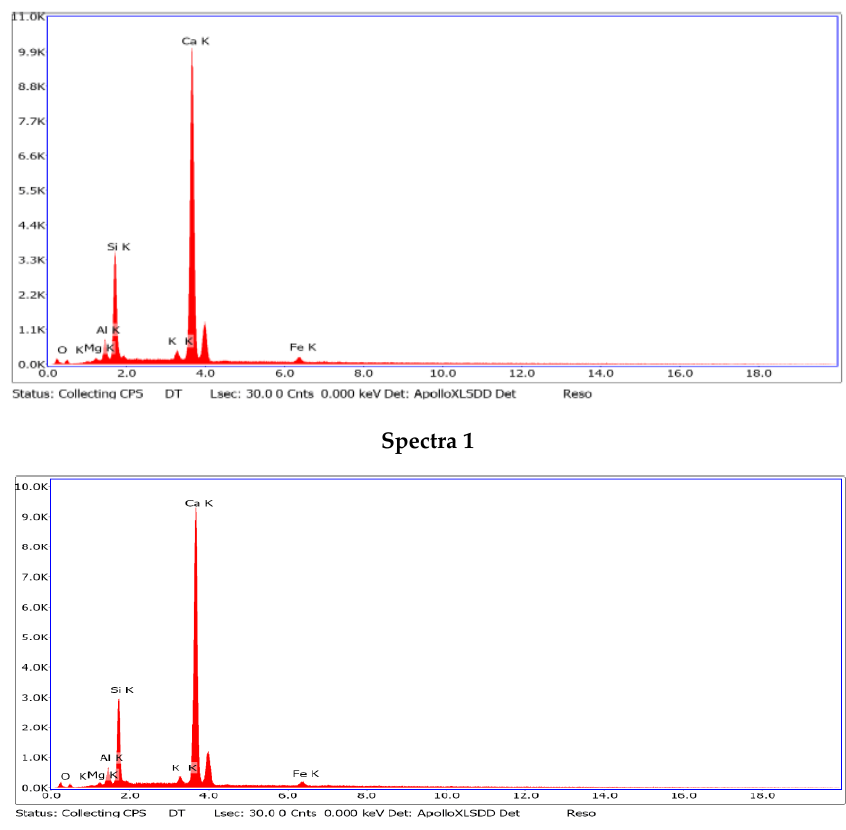
Figure 3. EDS spectra phases of the initial marl. Phase spectra of the silicified marl bulk after thermal treating at 700 °C revealed the presence of larnite Ca 2 SiO 4 (Figure 4).